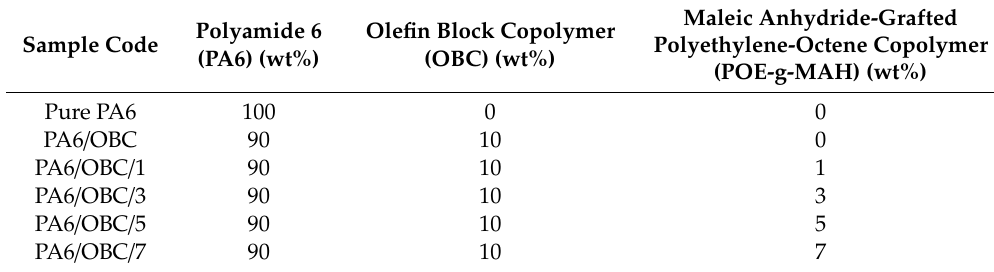
Table 1. The compositions of the studied